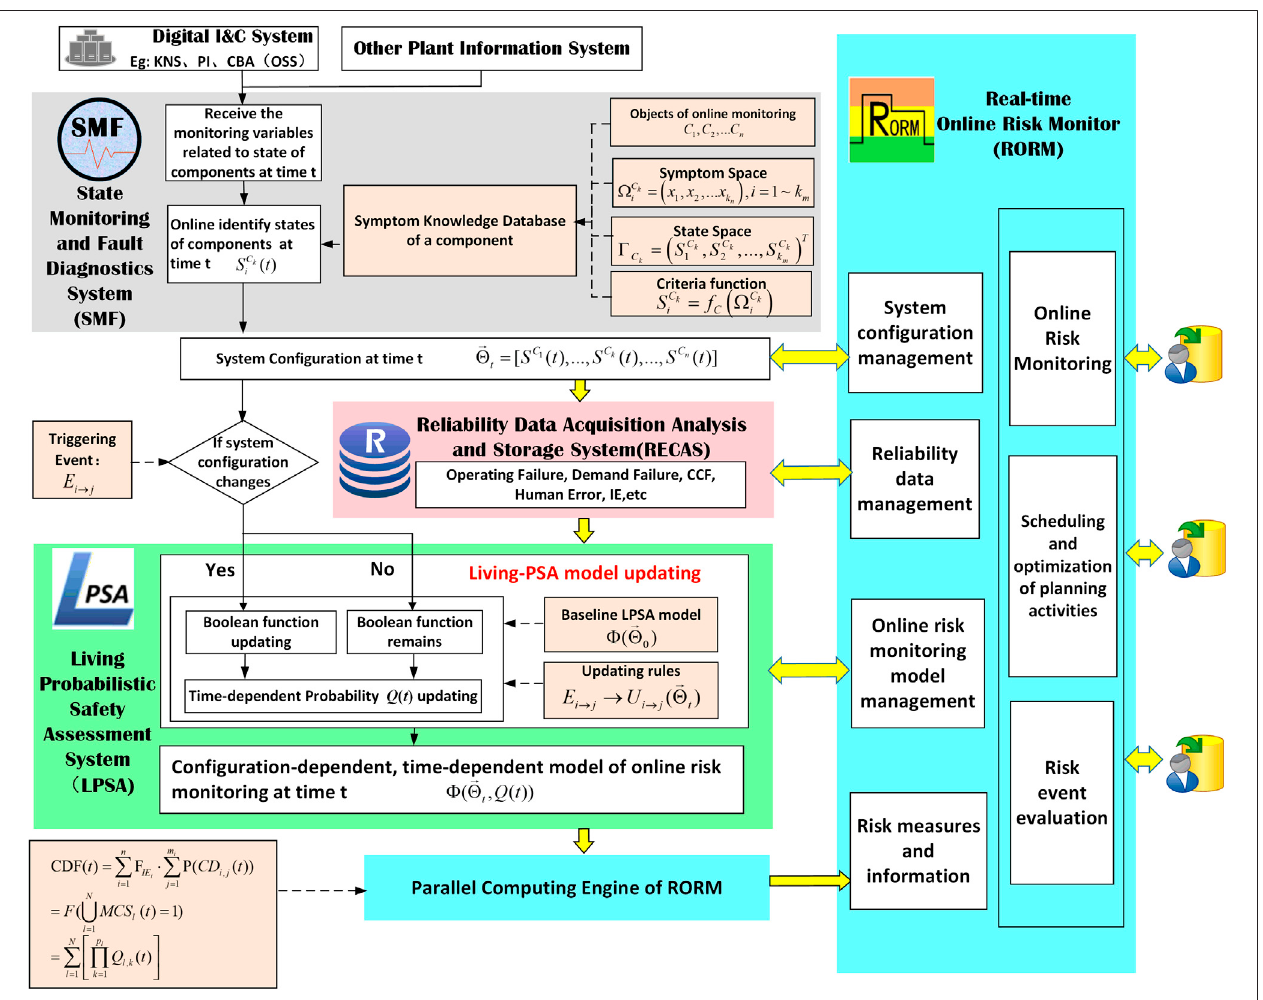
FIGURE 1 | Architecture of an integrated platform for nuclear power plant real-time online risk monitoring and management (IRORM).